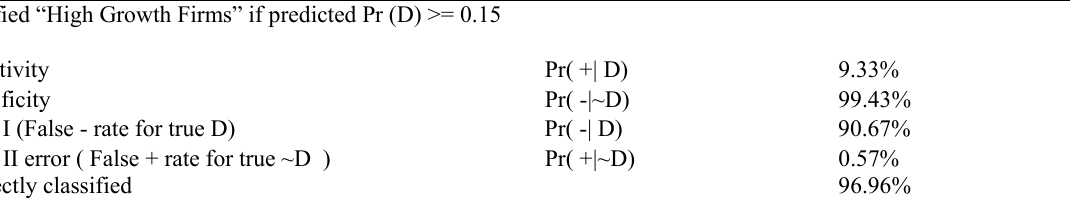
Type I error and Type II error (Classification Matrix) High Growth Firms (D) Non High Growth Firm ( ~D) Total High Growth Firms (+) Non High Growth Firm (-)